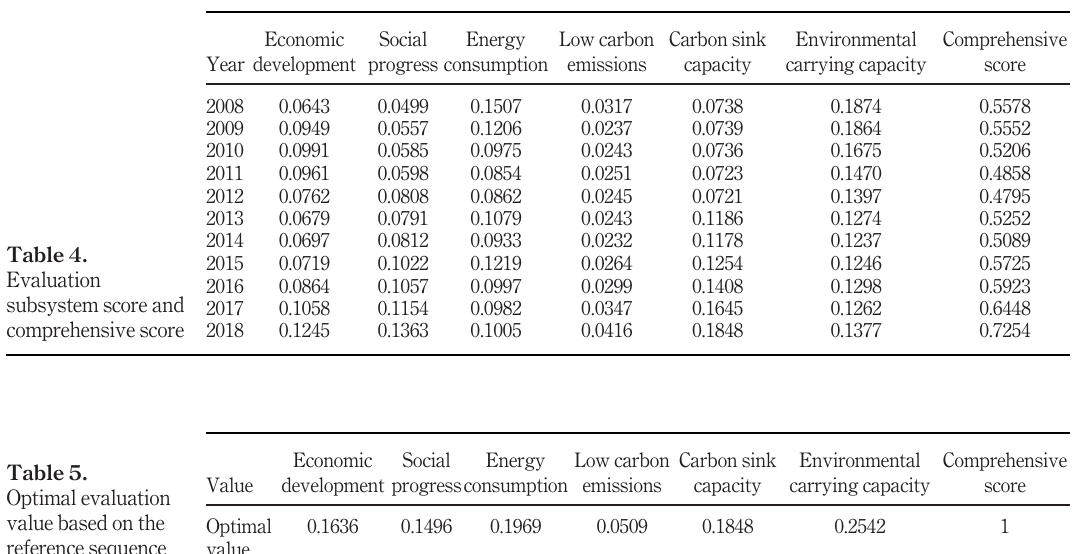
Table 5. Optimal evaluation value based on the reference